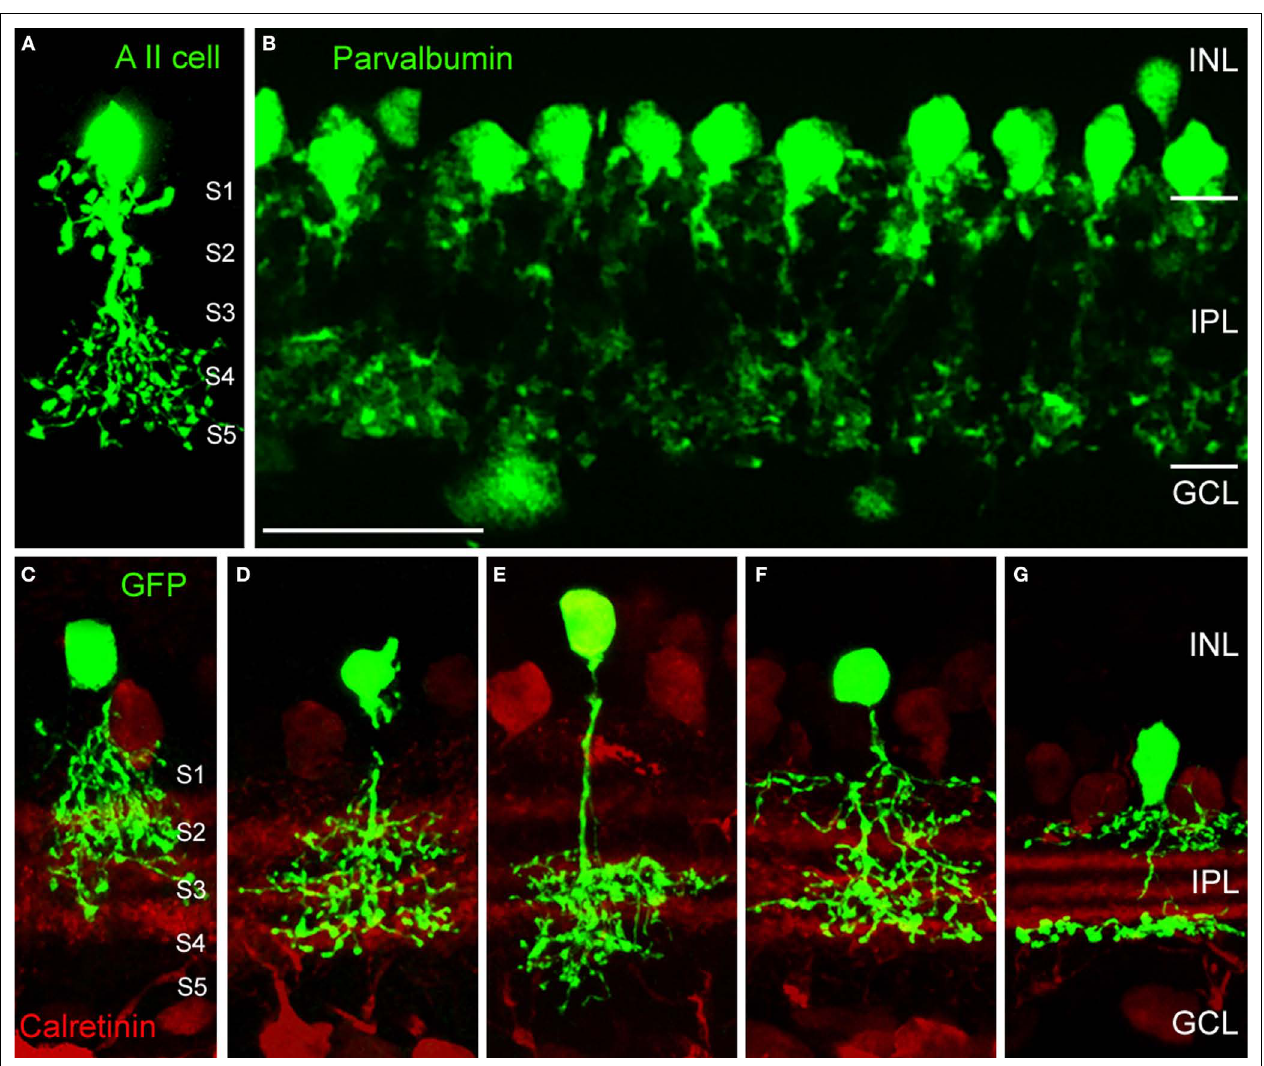
FIGURE 2 | Morphological types of glycinergic amacrine cells (modifi ed from Heinze et al., 2007; Weiss et al., 2008). (A) Vertical section of an AII amacrine cell of the mouse retina that was fi lled with neurobiotin during patch-clamp recordings. The IPL is subdivided into 5 sublaminas of equal thickness. (B) The array of AII amacrine cells of the rat retina immunostained